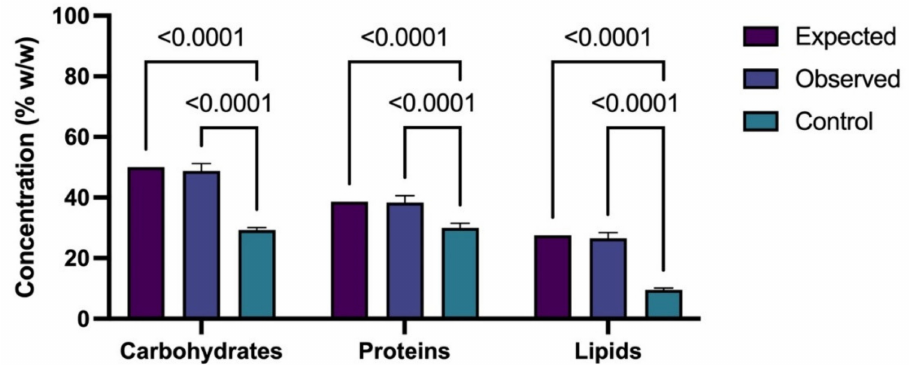
Figure 6. One-way ANOVA between the expected and obtained results to produce carbohydrates and lipids in Chlorella sp. UFPS019 and proteins in Scenedesmus sp.